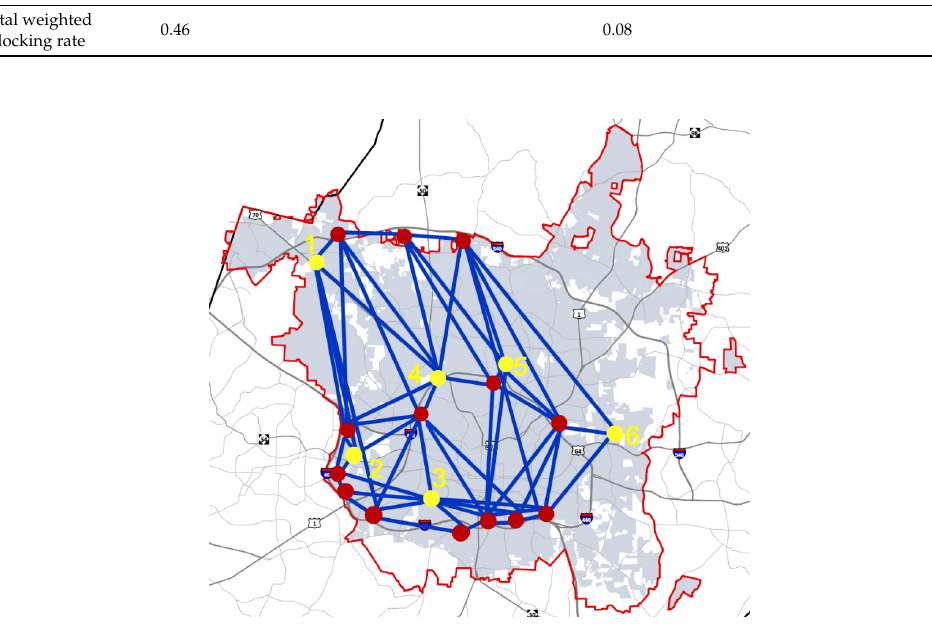
Figure 4. The network of Raleigh city